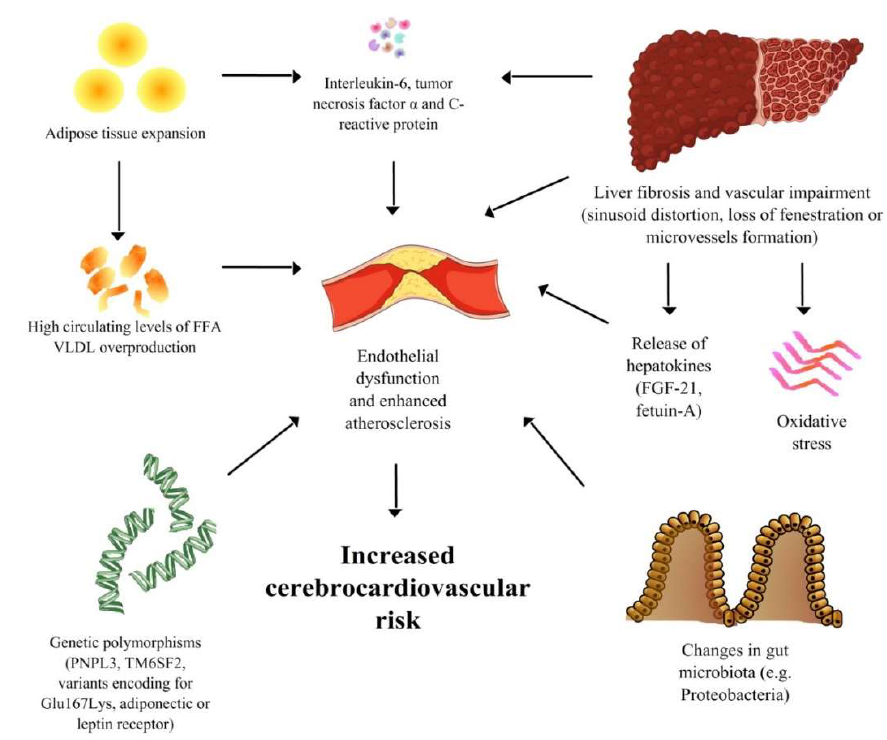
Figure 1. A Spotlight on the Pathogenesis of Cardiovascular Risk Associated with Non-Alcoholic Fatty Liver Disease.